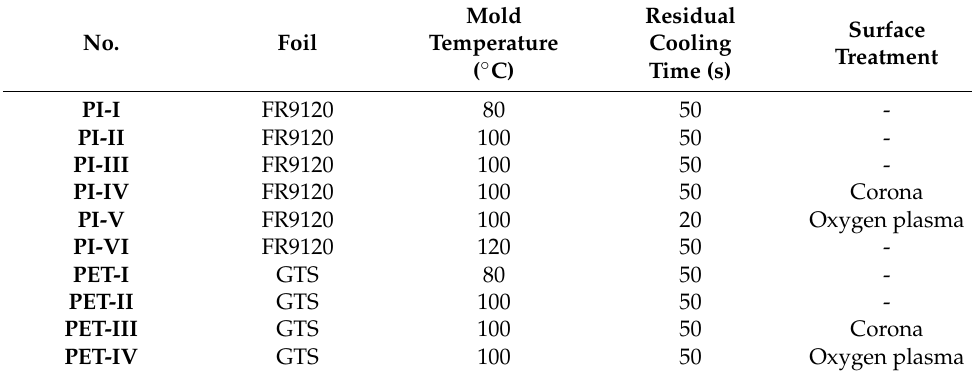
Table 2. Listing of the over-molded parts for peel